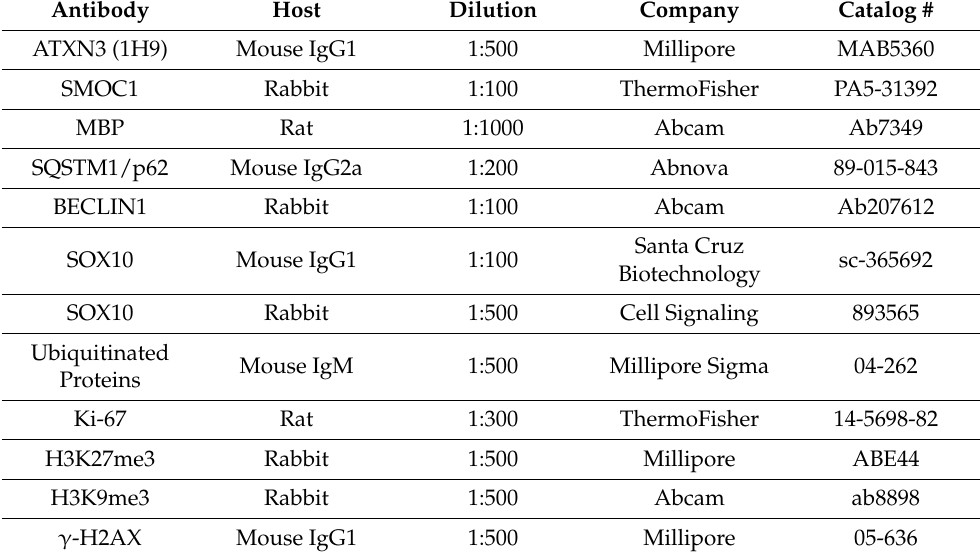
Table 1. List of primary antibodies used for oligodendrocyte immunocytochemistry.